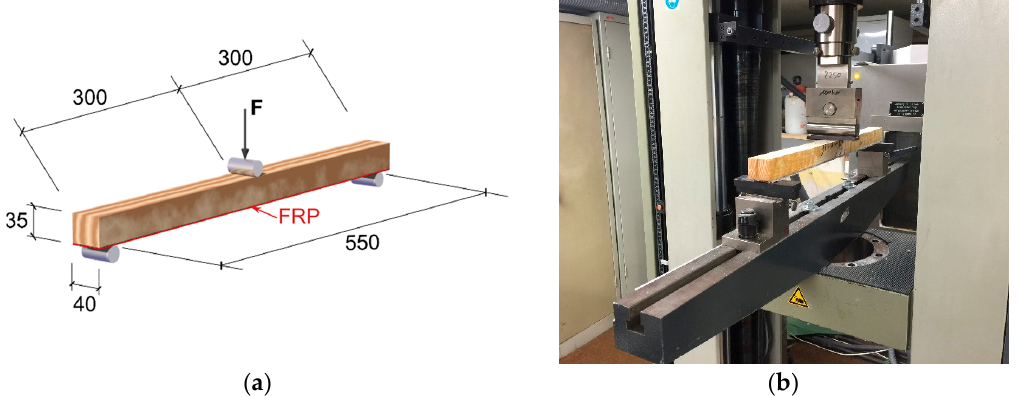
Figure 3. Test setup of bending test for FRP–wood beams (unit: mm).